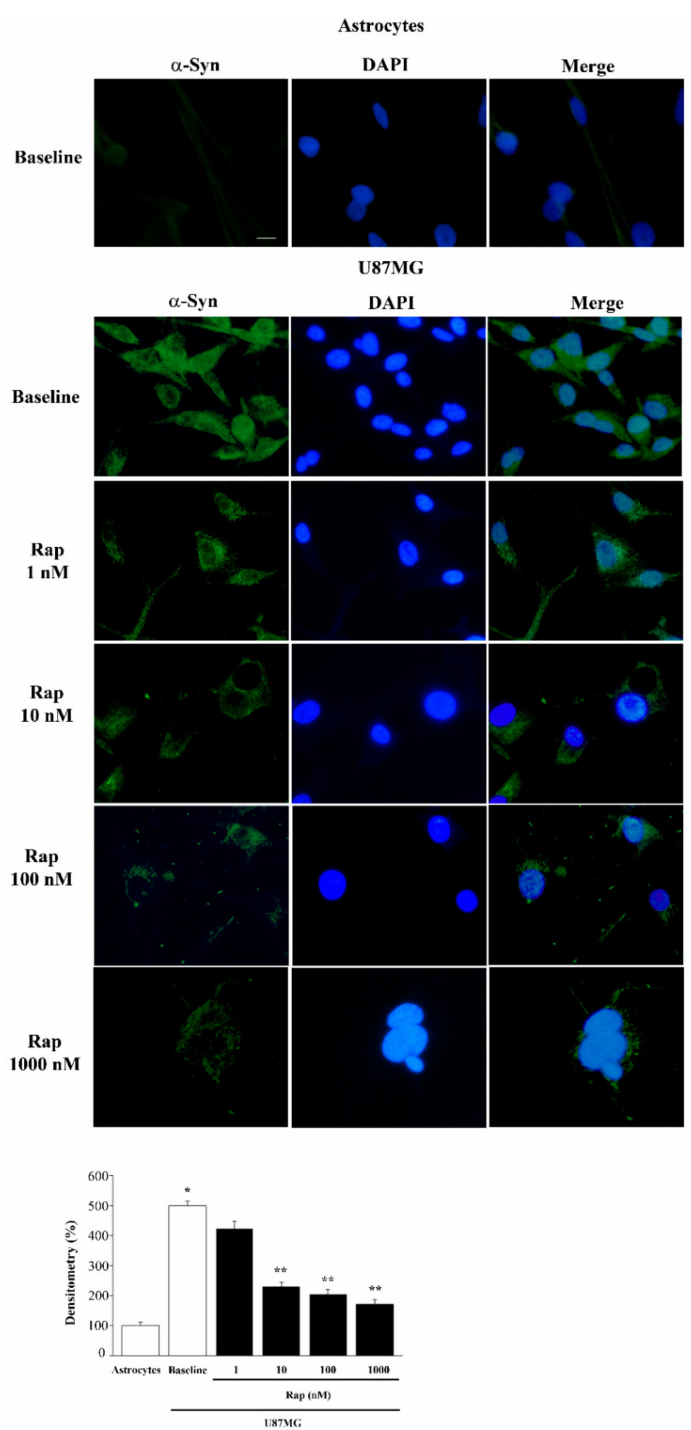
Figure 5. Rapamycin dose-dependently reduced α -syn immuno-fluorescence. Representative pictures of α -syn-positive astrocytes and U87MG cells, in baseline conditions and following rapamycin (Rap) exposure. Each cell nucleus is visualized using DAPI (blue). In these cells, the amount of α -syn is stained by a green fluorescent-labeled secondary antibody (Alexa 488, green). The graph reports the densitometry of α -syn immuno-fluorescence within astrocytes compared with U87MG cells, in baseline conditions and following rapamycin exposure. Data are given as the mean percentage ± SEM of optical density for each experimental group (assuming controls as 100%) obtained from n = 30 cells per group in a total of N = 3 independent experiments. * p < 0.05 compared with astrocytes; ** p < 0.05 compared with baseline and Rap 1 nM in U87MG. Scale bar = 12 µ